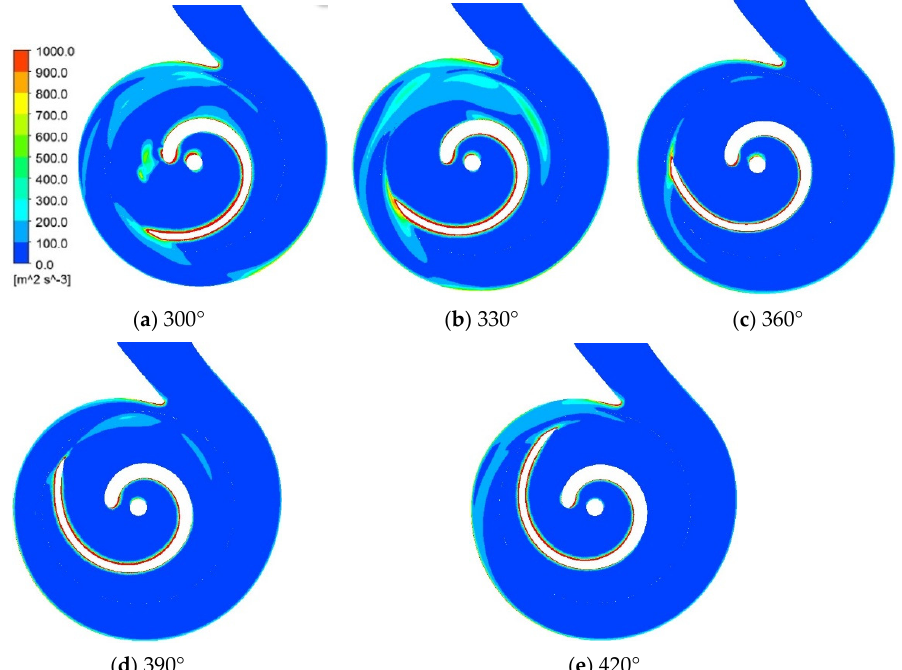
Figure 8. Turbulence dissipation rate of single blade centrifugal pump with different wrap angle.